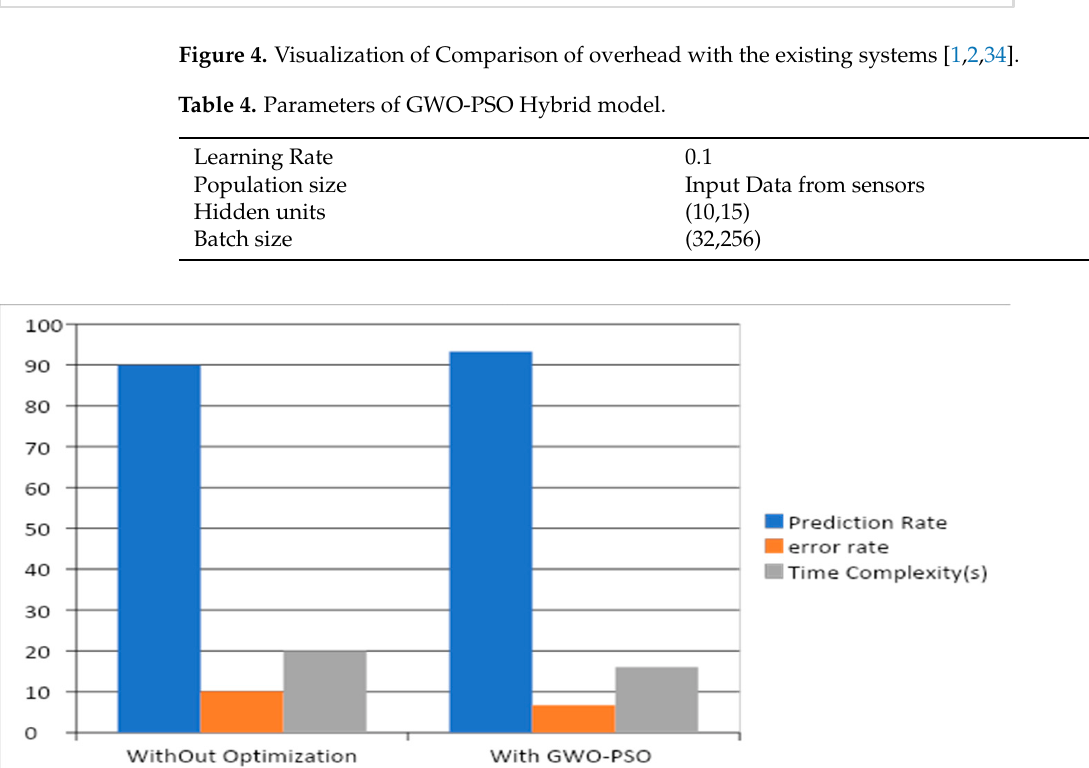
Table 5. Instances Gas costs. No.of Instances